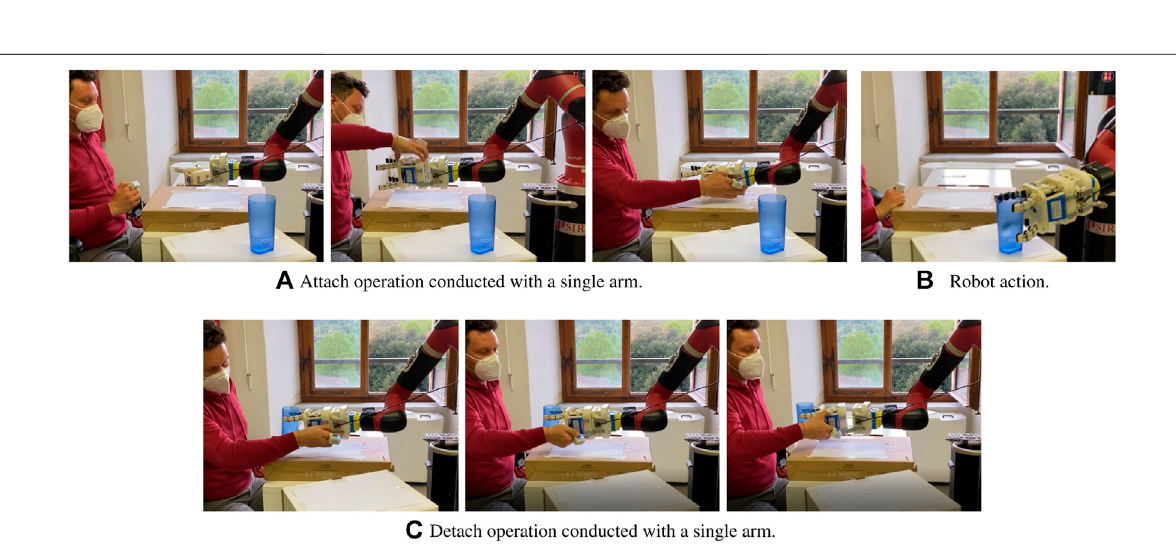
Frontiers in Robotics and AI |